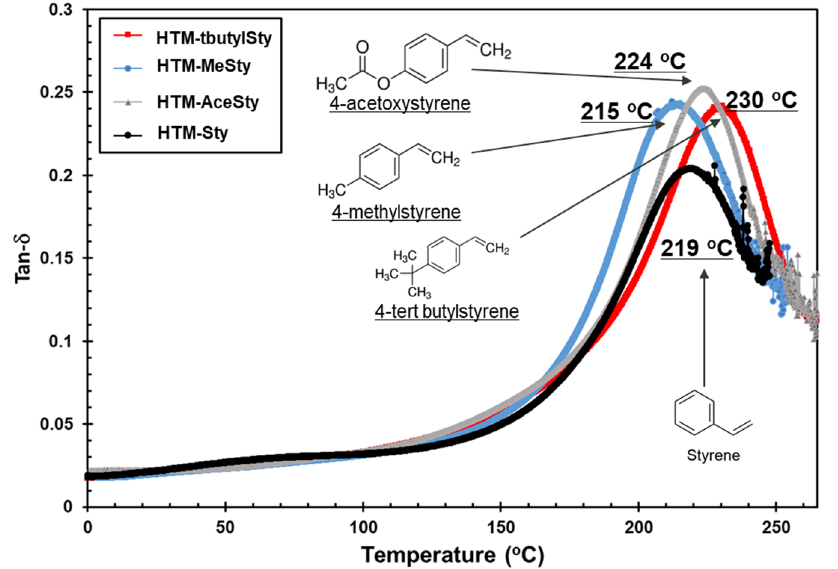
Figure 6. Tan- δ of thermosets featuring copolymers with styrene diluents. Thermosets feature HTM:diluents in a 1:1 mass ratio.